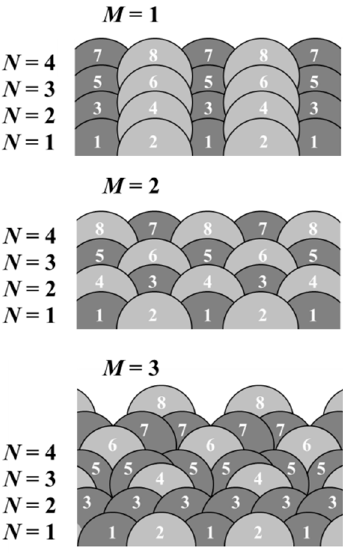
Figure 15. Schematic illustrations for different printing manners ( M ) to form continuous inkjet lines when using interlacing printing procedure.